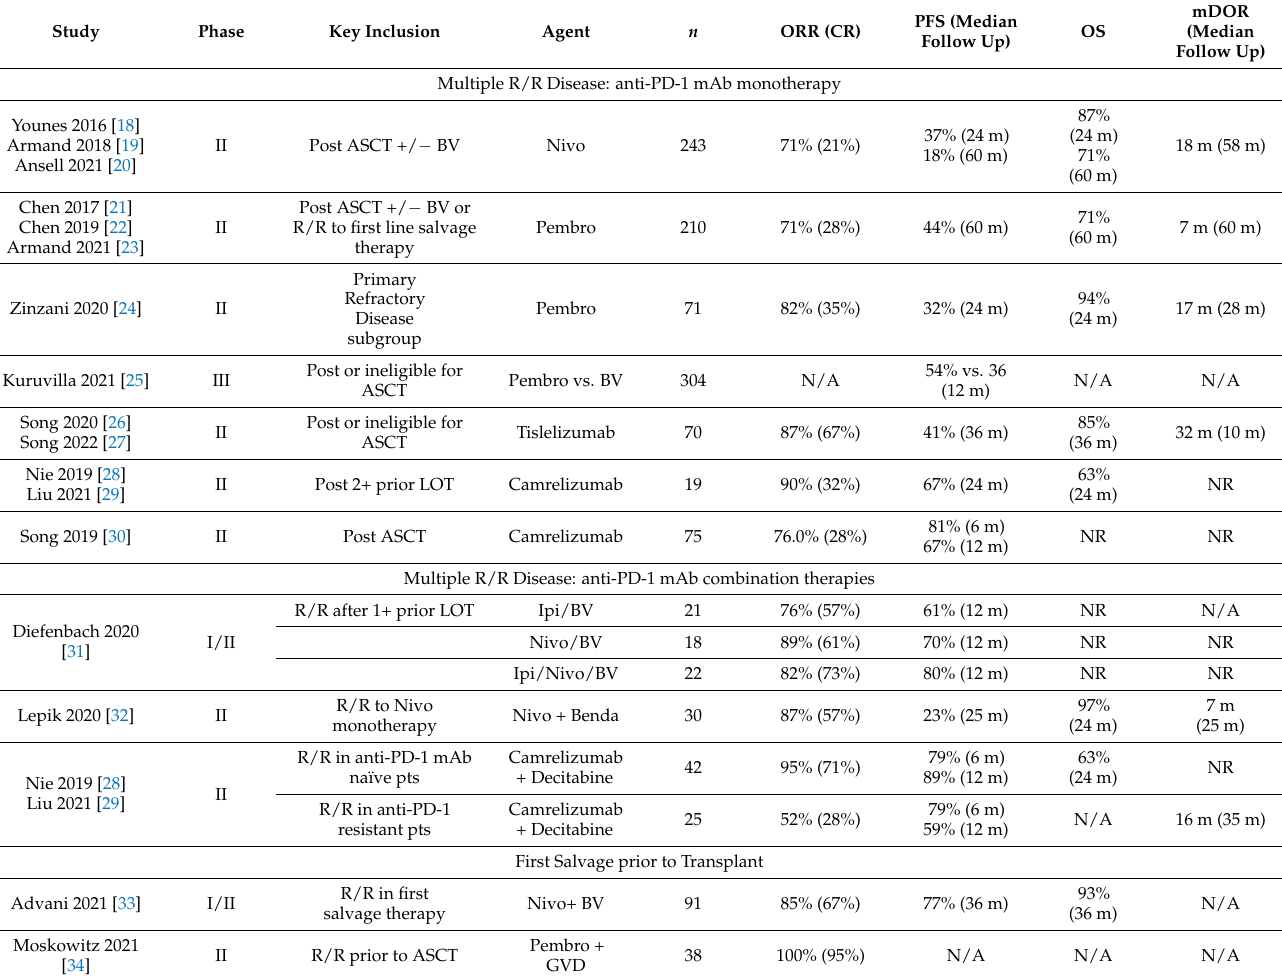
Table 1. Phase II and III Studies Evaluating Anti-PD1 mAb Therapies in Hodgkin’s